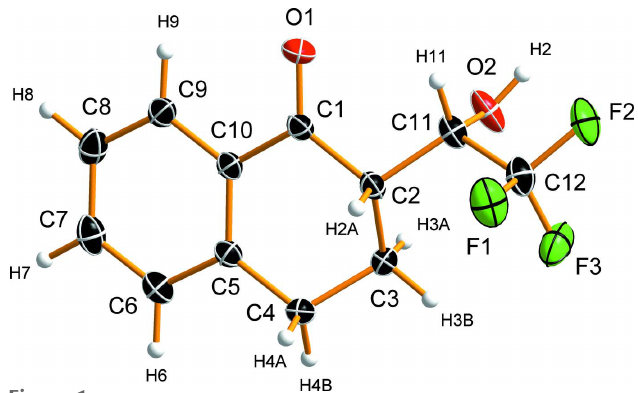
Figure 1 Molecular structure of the title compound and the atom-labeling scheme. Displacement ellipsoids are shown at the 50% probability level and hydrogen atoms are depicted as spheres of arbitrary